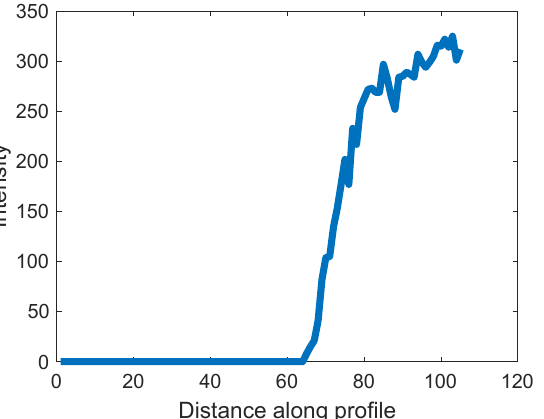
Figure 7. Collected light intensity profile along spray plume line, starting from the nozzle hole extending to the vessel wall.